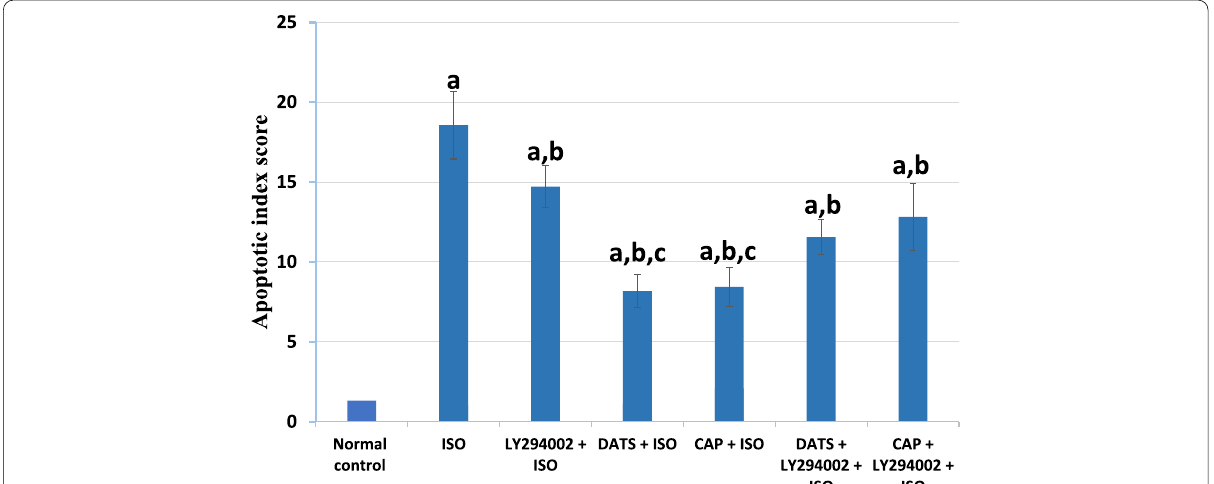
Fig. 5 Effect of treatment on cardiac histopathological scoring of apoptosis in the studied groups. Data are presented as mean was set at p < 0.05, n 6. ISO: Isoproterenol induced AMI group (85 mg/kg/d), LY294002 = Diallyl trisulfide pretreated group (40 mg/kg d), CAP PI3K inhibitor pretreated group,